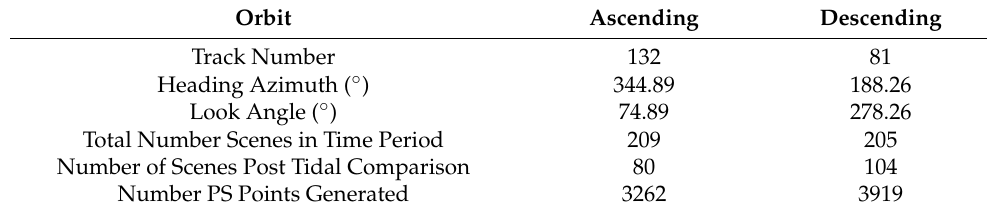
Table 2. SLC scene acquisitions, total number of scenes processed and processing software following comparison with tidal data from Portsmouth